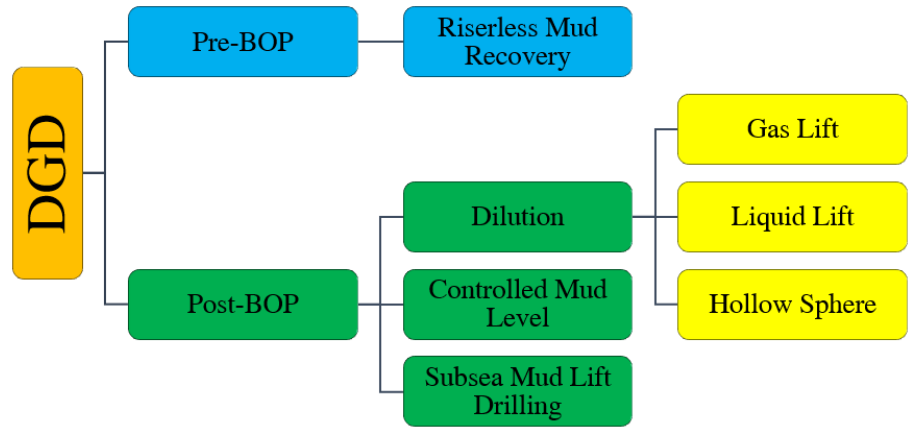
Figure 2. Classification of various dual gradient drilling methods before and after installing blowout preventer.